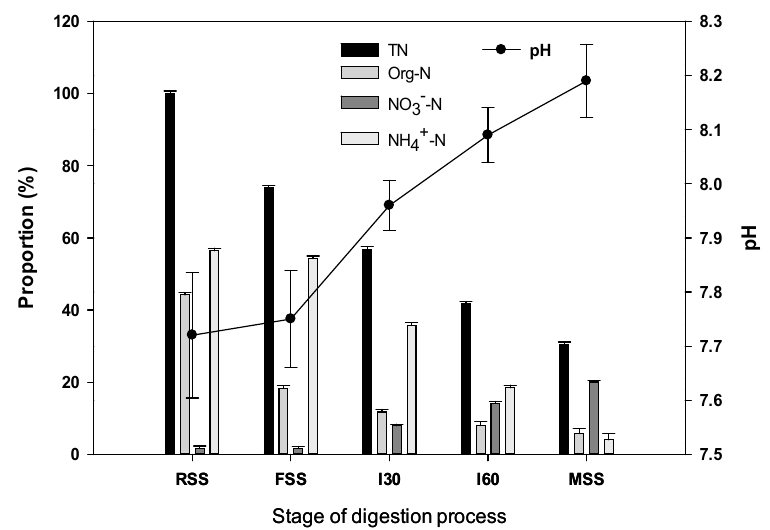
Figure 4. Changes in proportion of N content and pH corresponding to each digestion stage. TN, total nitrogen; Org-N, organic nitrogen; NO 3 − -N, nitrate; NH 4+ -N, ammonium. Error bars indicate standard error.